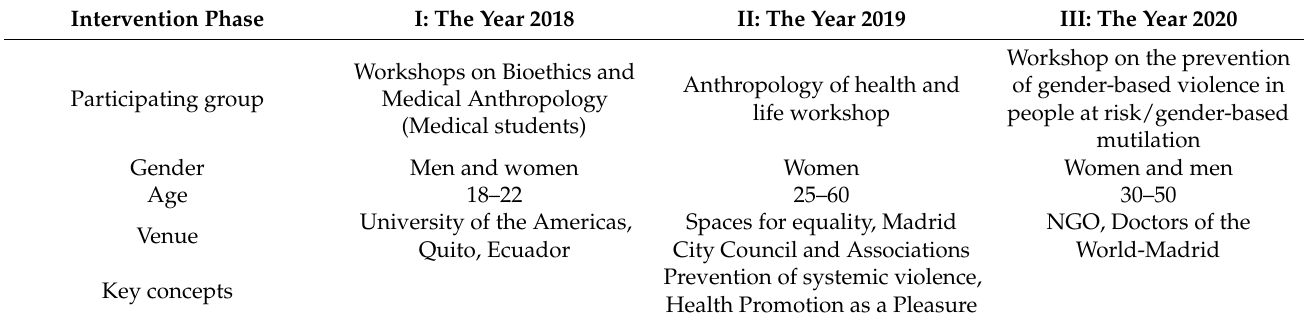
Table 2. Applied research or